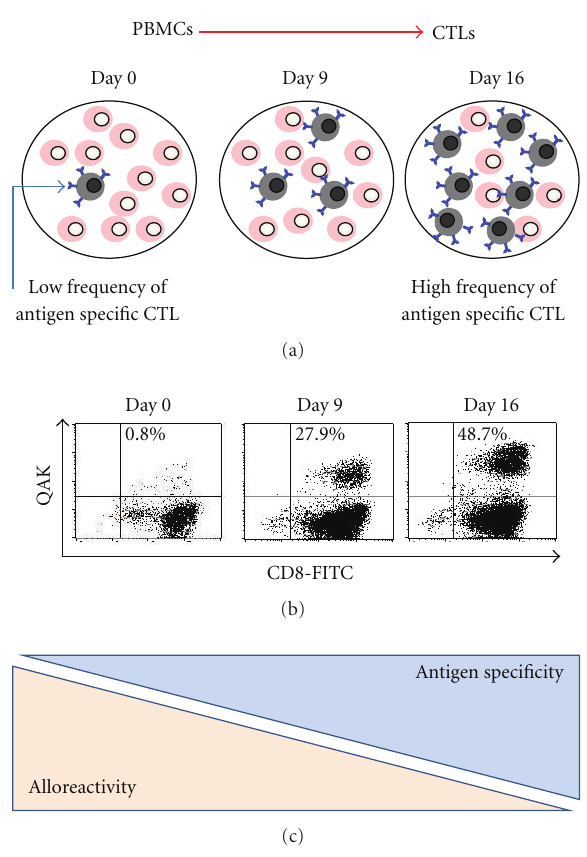
Figure 1: Increased frequency of antigen-specific CTLs after in vitro stimulation. (a) illustrates the low frequency of antigen- specific CTLs present in peripheral blood and the subsequent enrichment after antigen stimulation. (b) shows the enrichment of QAKWRLQTL- (HLA-B8-restricted EBV epitope-) specific T cells in a seropositive donor as evaluated by tetramer analysis. (c) illustrates the inverse correlation between the frequency of antigen- specific and alloreactive T cells in peripheral blood (left) and in vitro expanded CTLs